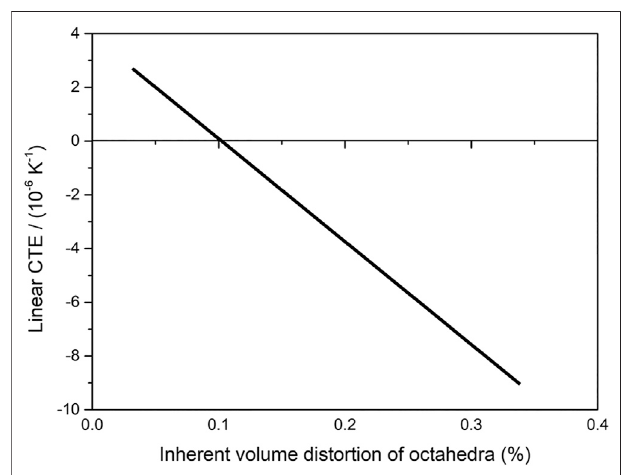
FIGURE 7 | Schematic representation of the dependence between linear CTE and inherent volume distortion of octahedra. The increase of inherent volume distortion of A O 6 corresponds to decrease in linear CTE (styled from data in Marinkovic et al.,